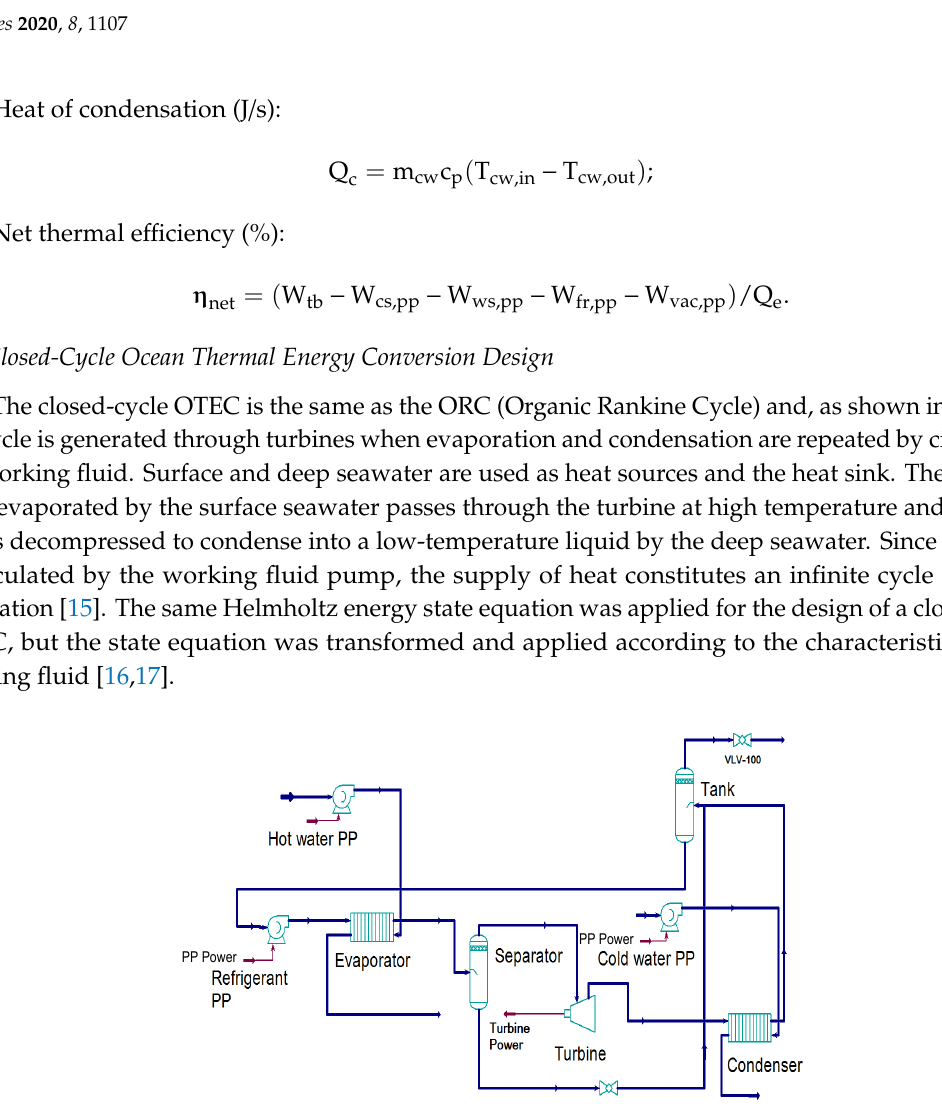
Figure 3. Closed-cycle ocean thermal energy conversion (OTEC).